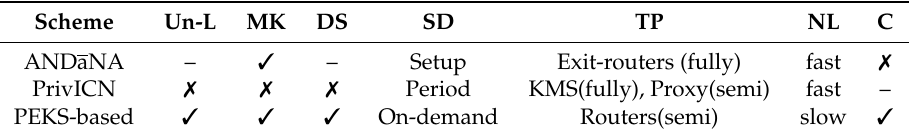
Table 2. Comparison between PEKS-based NDN and other